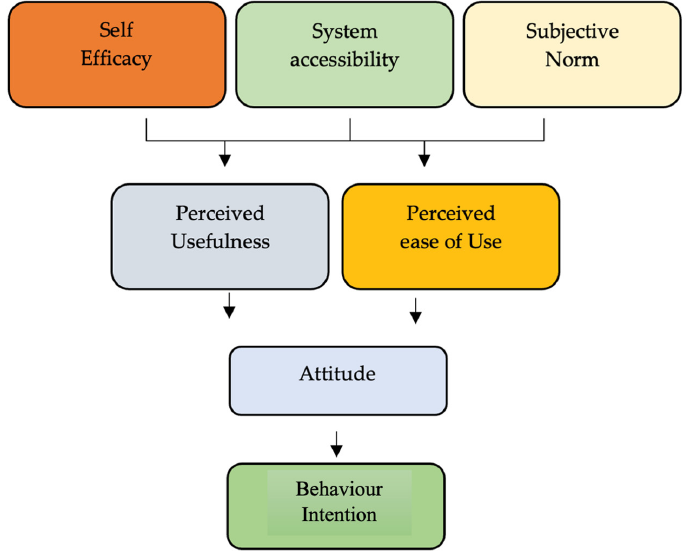
Figure 1. Research Framework.